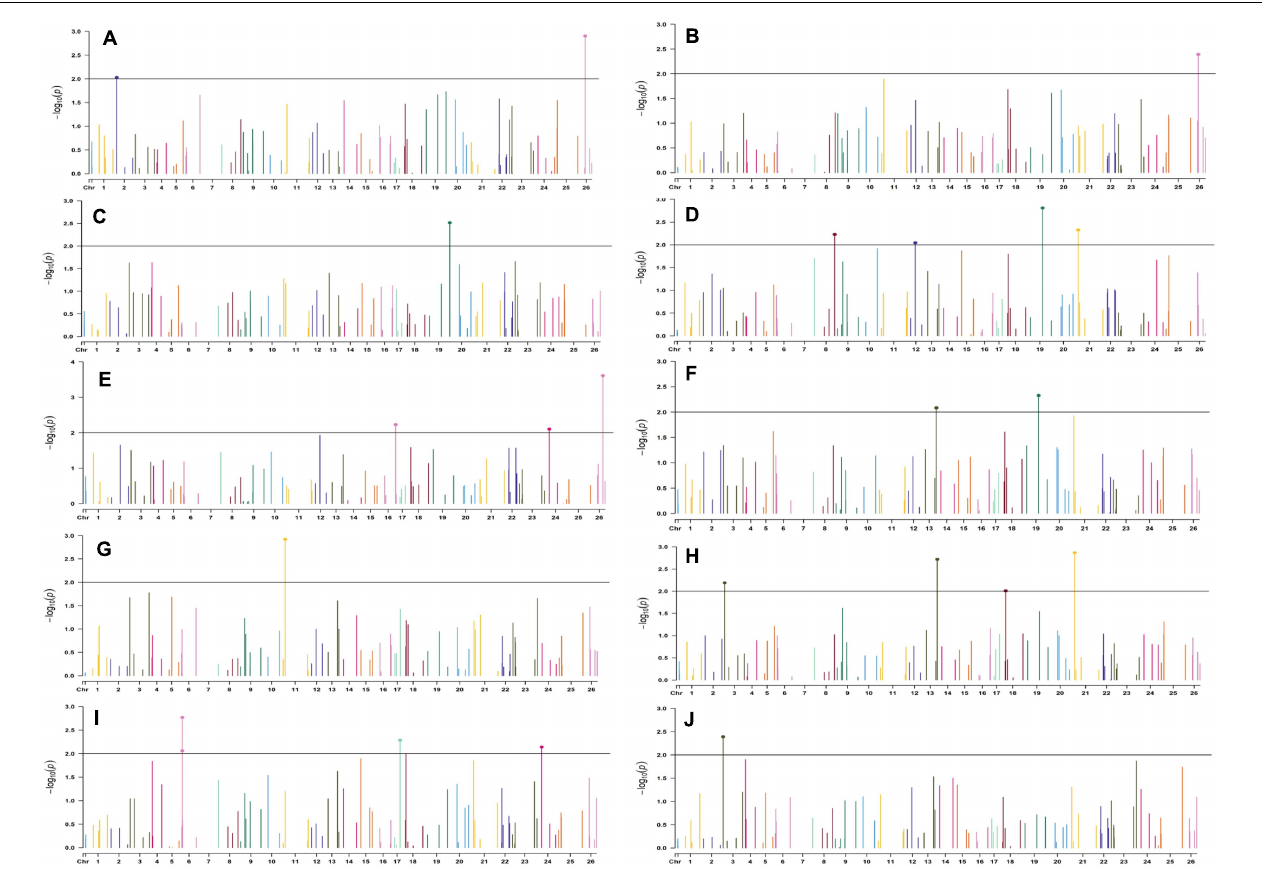
FIGURE 5 | Manhattan plots for the early sown environment of 2018 for various traits under study by the MLMM model. Significant marker above threshold {at –log10 ( p ) > 2} is highlighted with bold dot head on the marker’s line. (A) Days to first flower, (B) plant height, (C) number of monopods, (D) number of bolls per plant, (E) boll weight, (F) seed cotton yield per plant, (G) ginning out turn, (H) lint yield, (I) seed index, and (J) lint